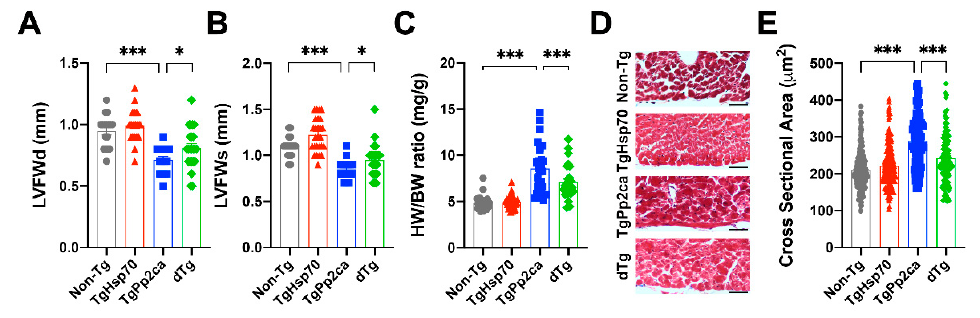
Figure 3. Overexpression of HSP70 prevents PP2CA-driven dilated cardiomyopathy. ( A , B ) Echo- cardiograms revealed that the LV free wall of TgPP2CA mice was significantly thinner than that of their non-Tg littermates, and this change was reversed in dTg mice. Cohort size, nTg: 18, TgHSP70: 27, TgPP2CA: 16, dTg: 23. ( C ) Overall increase in heart weight was observed in TgPP2CA mice, without any changes in body weight, while it was attenuated in dTg mice. Cohort size, nTg: 33,